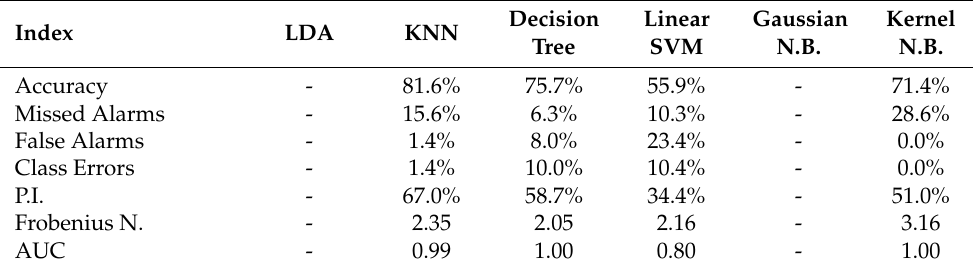
Figure 6. Mahalanobis Distance NI m vs. Linear Combination NI α . Healthy conditions of the machin- ery are indicated as Class 0, while the damage is defined as Class k , where k = 2, 3, 5, 7, 9. Table 2. Comparison indices obtained with the features in the original space.